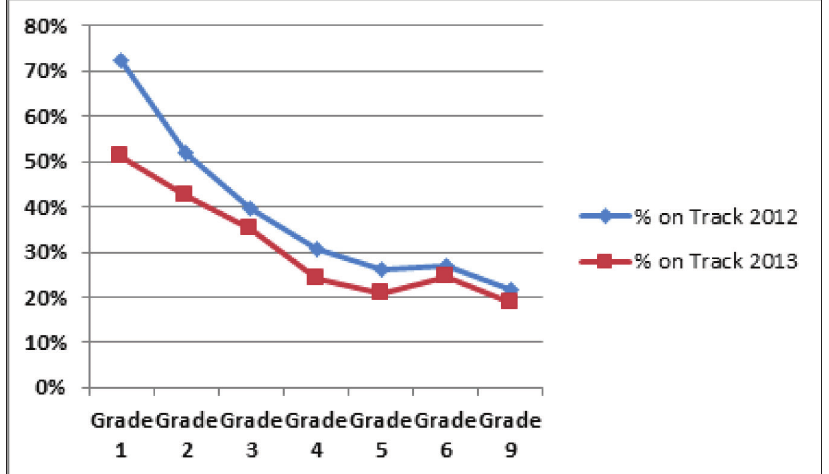
Figure 4: Percentage of entering cohort on track in various grades in ANA 2012 and ANA 2013 (Source: Own calculations from ANA